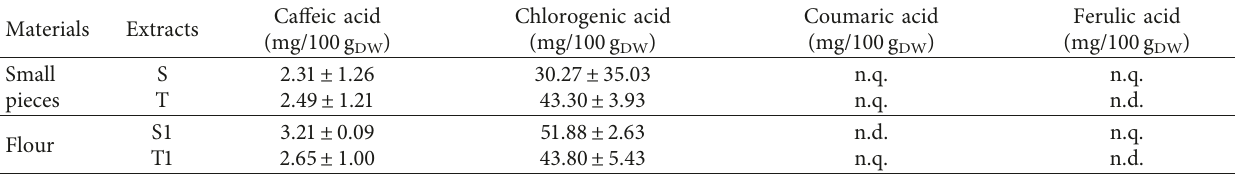
Table 2: Cinnamic acid composition of the different breadfruit samples.